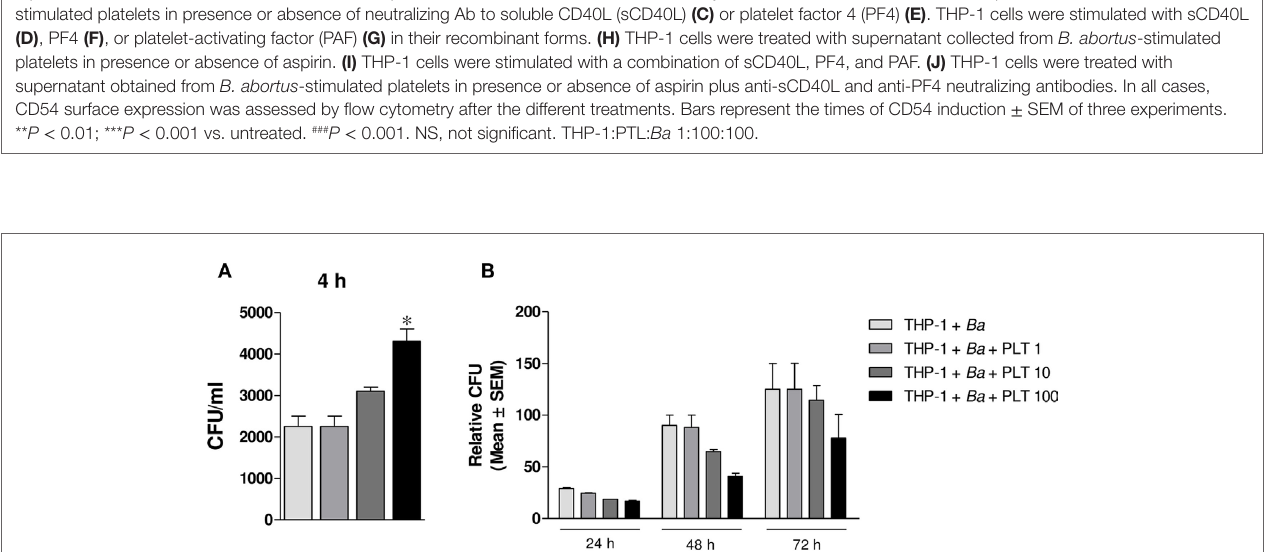
FigUre 9 | Platelets promote monocyte invasion by Brucella abortus but improve its control. THP-1 cells were infected with B. abortus in presence or absence of platelets at different ratios (THP-1:PLT 1:1, 1:10, and 1:100) for 4 h and then incubated with antibiotics for 24, 48, or 72 h. (a) Quantification of monocyte invasion by B. abortus after 4 h. Data are expressed as colony-forming units (CFU) per ml. (B) Quantification of monocyte invasion by B. abortus at different times post-infection. Data are expressed as relative CFU calculated as: CFU per ml at each time point (24, 48, or 72 h) relative to the CFU per ml measured for the same condition at 4 h.